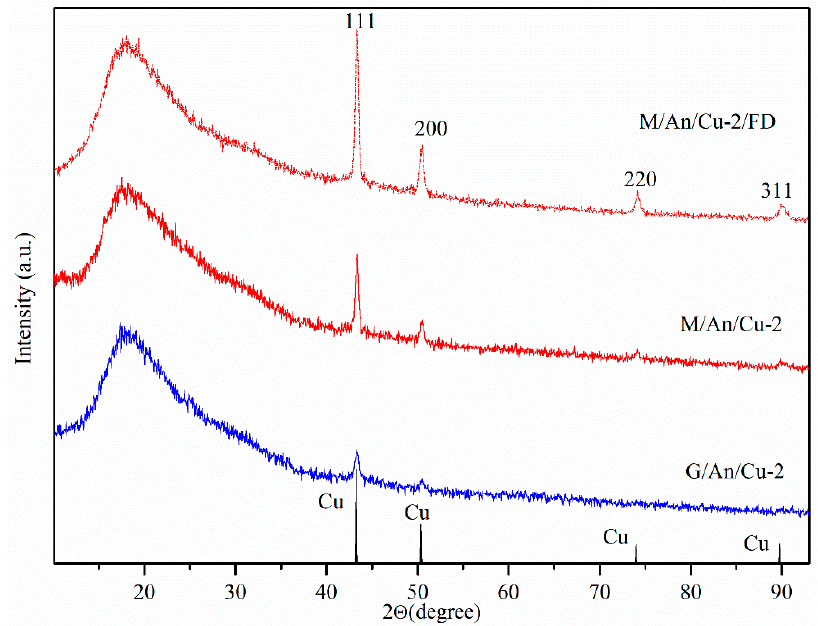
/ An / Cu-2 and G / An / Cu-2 obtained by Method Figure 7. XRD patterns of reduction products M/An/Cu-2 and G/An/Cu-2 obtained by Method 2. Figure 7. XRD patterns of reduction products M